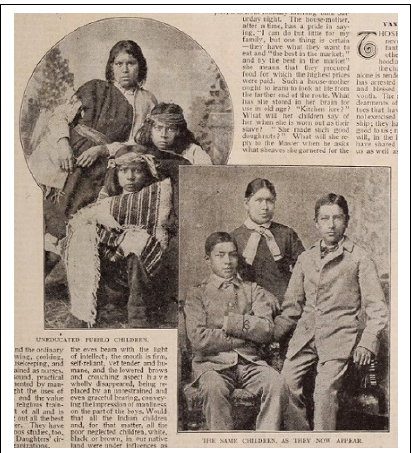
Figure 3. Turning “Other” into “Self”. The Christian Herald , June 19, 1895, p. 403. The coincidence of Christian benevolence and a desire to be fair-minded did sometimes check the worst excesses of cultural imperialism. For example, the Herald ’s initial coverage of the Ghost Dance disturbances and the subsequent massacre at Wounded Knee, South Dakota, reflected disdain for un-Christianized Native peoples. The first headline from Wounded Knee blared, “Indian Treachery”. As more information emerged, however, the Herald began to change its tune. Within weeks of the massacre, it shifted blame from